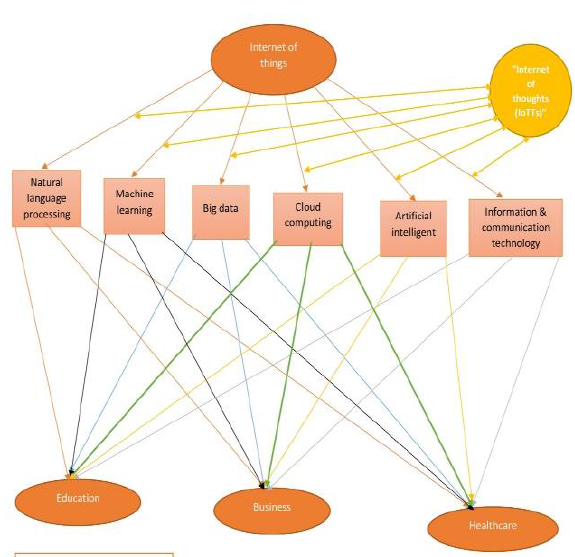
Figure 4. internet o things on human psychology for education, healthcare and business by owner Figure 4 above, provide a detailed example